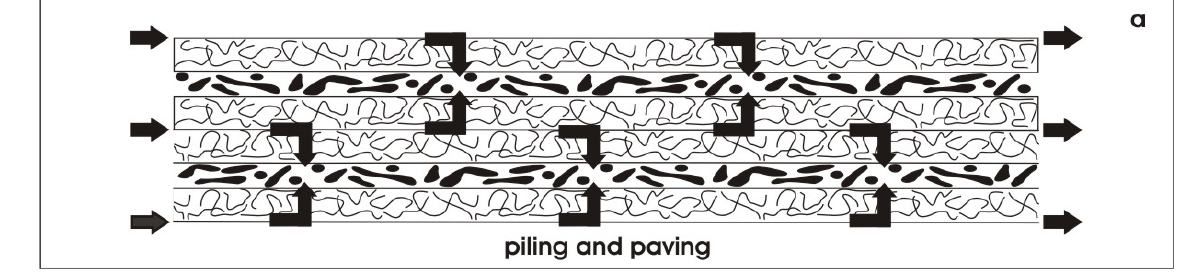
Figure 11. The space between the polyester fibers in piled and paved specimens could be used for supply of culture medium. Arrows indicate the possible flow of medium and respiratory gas during perfusion